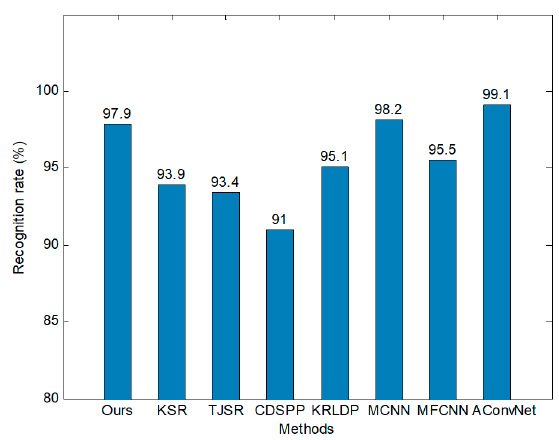
Figure 6. Comparison of different methods under the standard operation conditions (SOCs) test.